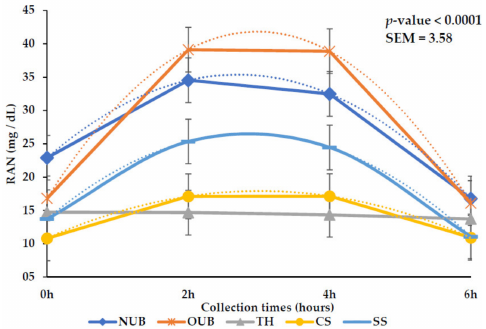
Figure 1. Effect of roughage × collection time interaction ( p < 0.01) on rumen ammonia nitrogen (RAN) concentration. NUB: y = − 1.7088x 2 + 9.2325x + 22.91; OUB: y = − 2.8188x 2 + 16.793x + 16.82; CS: y = − 0.7837x 2 + 4.7175x + 10.82; SS: y = − 1.5606x 2 + 8.9253x + 13.73.